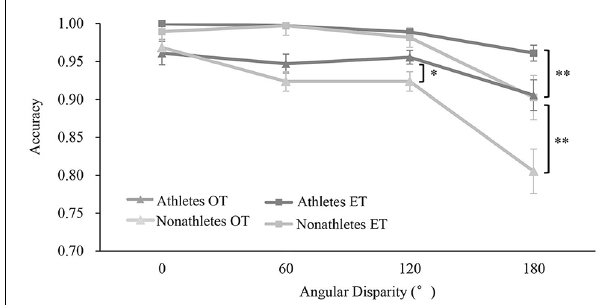
FIGURE 2 | Accuracy (M ± SE) of athletes and nonathletes with different transformation types. ∗ p < 0.05, ∗∗ p <